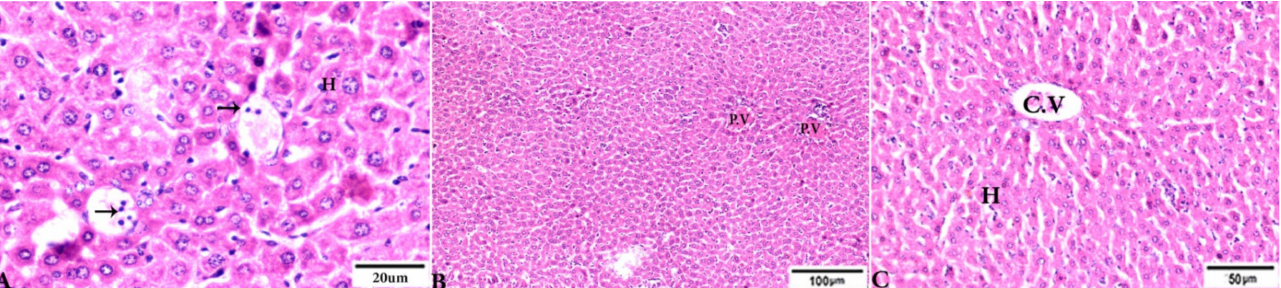
Figure 5. Photomicrograph of H&E-stained liver tissue sections from mice in the experimental groups: ( A ): liver tissue sections from mice in the Toxoplasma gondii -infected group treated with wheat germ oil (G4) showing normal hepatocellular structure (H); parasitic tissue cyst contains bradyzoites (arrows). ( B , C ): Liver tissue sections from mice in the combined propolis and wheat germ oil treatment group (G5) showing: ( B ): normal portal structure with normal portal vein (P.V), normal central vein (C.V), and normal hepatocytes (H). The scale bar is provided below each